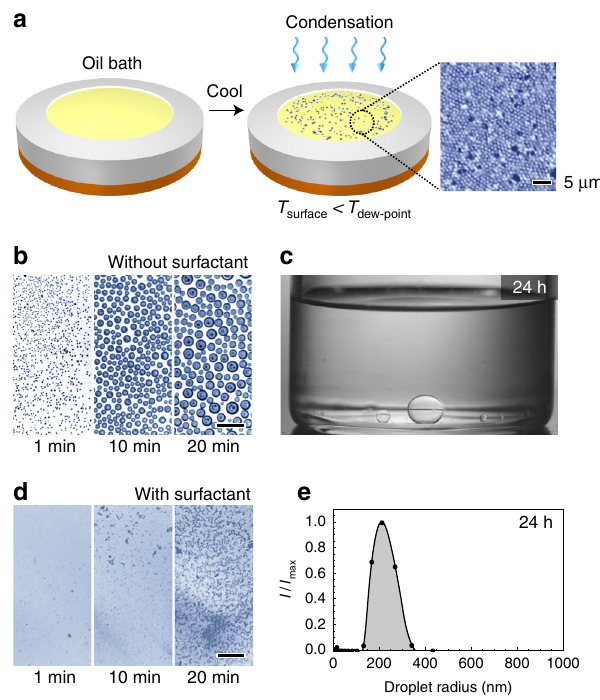
Fig. 1 Formation of nanoscale emulsions via condensation. a Experimental set-up: an oil bath is placed in a high humidity, temperature-controlled environment and then cooled below the dew point. Water droplets spontaneously condense onto the surface of the oil from the vapor phase. Optical image shows water-in-oil emulsions formed after 10 min of condensation (oil phase: dodecane with 0.1 mM Span 80). Scale bar depicts 5 μ m. b In the absence of surfactant, water droplets continually coalesce and grow on the surface of dodecane. c Without surfactant, the water phase eventually pools as one large drop at the bottom of the dodecane reservoir. d When surfactants are added to dodecane, a stable water-in-oil emulsion results after 30min of condensation (oil phase: dodecane with 100 mM Span 80). e DLS measurement taken 24h after the condensation process with surfactant shows the resulting emulsion has a peak radius of 215 nm and a polydispersity of 20% (oil phase: dodecane with 100 mM Span 80, condensation time: 30min). Scale bars in parts b and d depict 50 μ